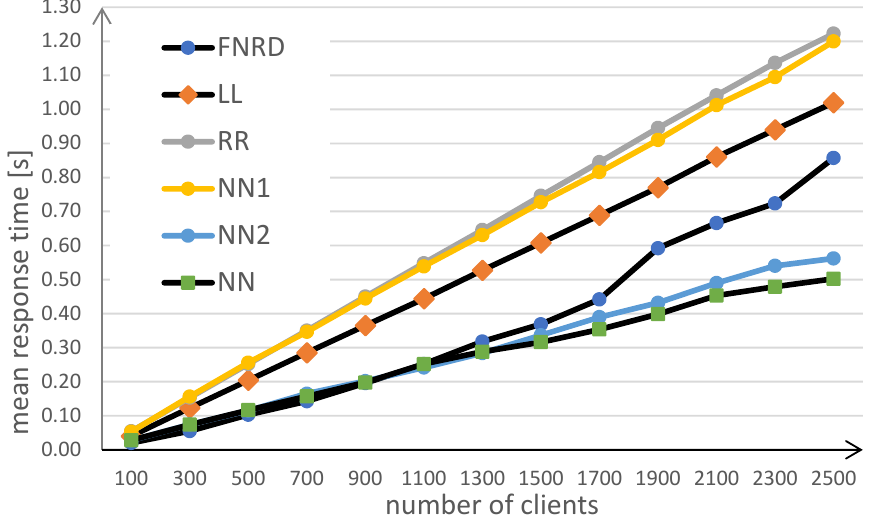
Figure 14. Results of the comparison of mean response time. Compared algorithms: the proposed